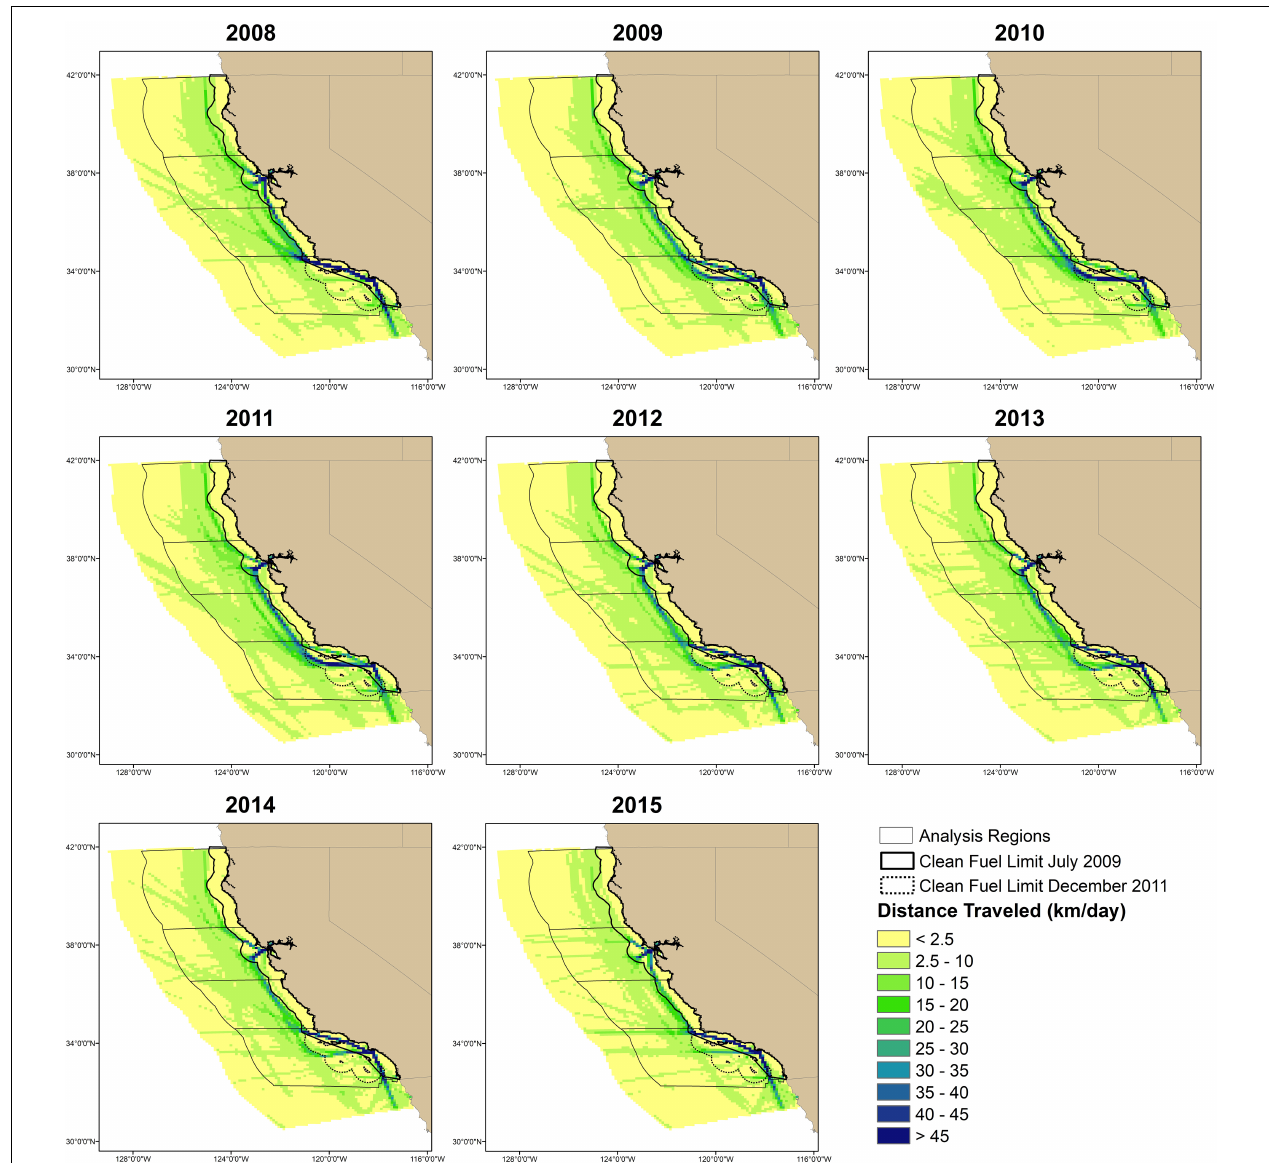
FIGURE 1 | Maps of distance traveled (km/day) by ships from July–December in a 10 × 10 km grid. Analyses were conducted in four regions that are named from north to south as north, San Francisco, central, and south. Traffic was classified into nearshore (2008 and 2015; defined as having more traffic within the July 2009 clean fuel boundary compared to offshore traffic) and offshore (2009–2011; defined as a majority of traffic outside the July 2009 clean fuel boundary) scenarios. Classification of the 2012–2014 traffic was done on a region-by-region